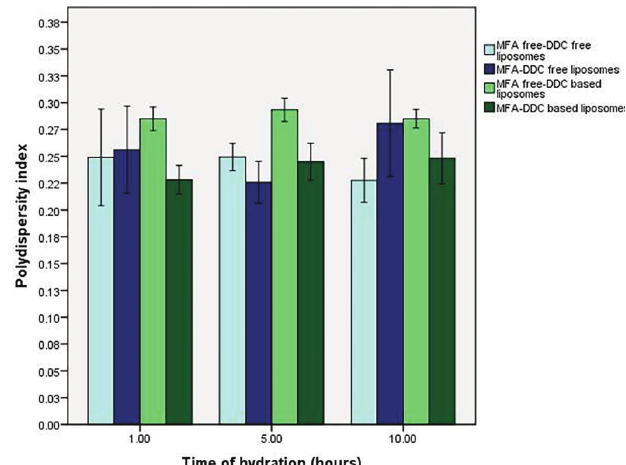
FIGURE 5 - Polydispersity index of the particles size when different liposomal components and hydration times were employed.